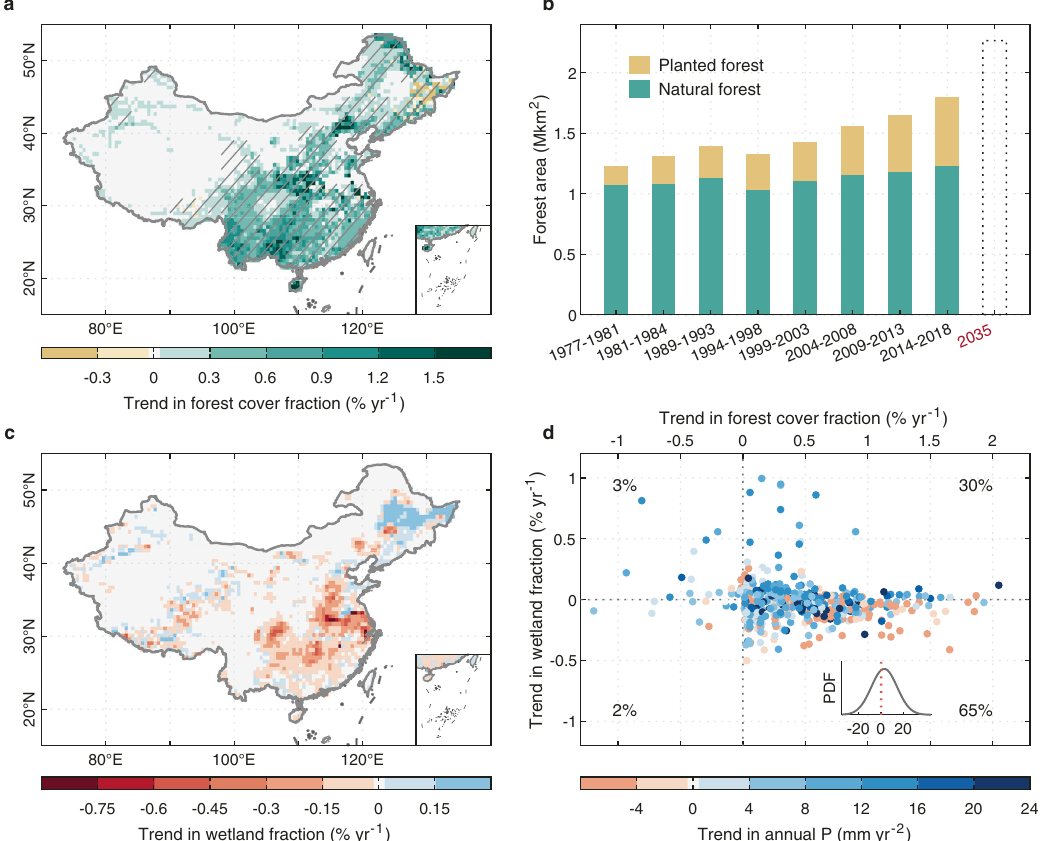
Fig. 1 Historical change of forest coverage and wetland extent in China. a Spatial pattern of trend in forest cover fraction from 2000 to 2016 from forest inventory data. b Temporal change in a forest area during the last four decades compiled from China ’ s 2nd ‒ 9th National Forest Inventory. c Spatial pattern of trend in wetland fraction from 2000 to 2015 from GIEMS-2. d Trend in wetland fraction versus trend in forest cover fraction from 2000 to 2015 across grid cells ( n = 562) in ( a ), ( c ). The color of each point shows the trend in annual precipitation (P) from GSWP3-W5E5. The inset at the bottom right of Fig. ( d ) indicates the probability density function of the trend in annual P across points in the fourth quadrant. The trends in Fig. ( a ), ( c ) are estimated by linear least-squares regression and hatching indicates the trend is statistically signi fi cant ( t -test, p < 0.05). Please note that the grid cells with a >10% rice paddy coverage are removed using the HYDE v3.2 data set to avoid wetland change induced by human activities in d